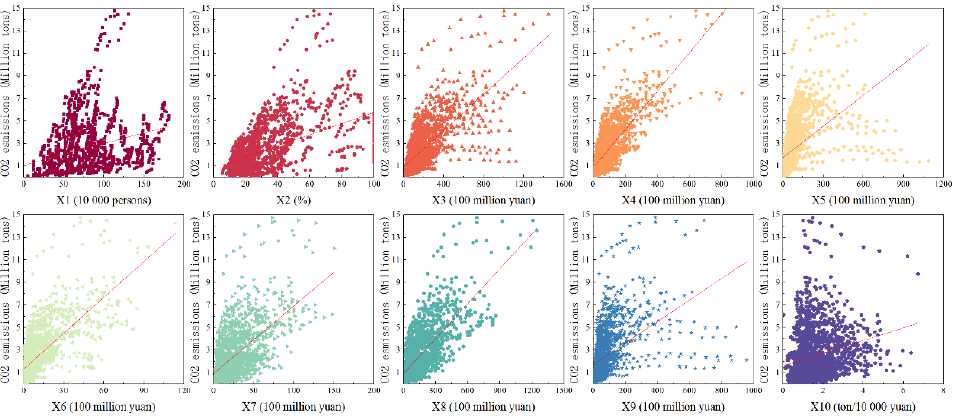
Figure 5. Scatter diagrams of the influence of detection factor on carbon emissions. Table 5. Rank change in importance of influencing factors of carbon emissions.